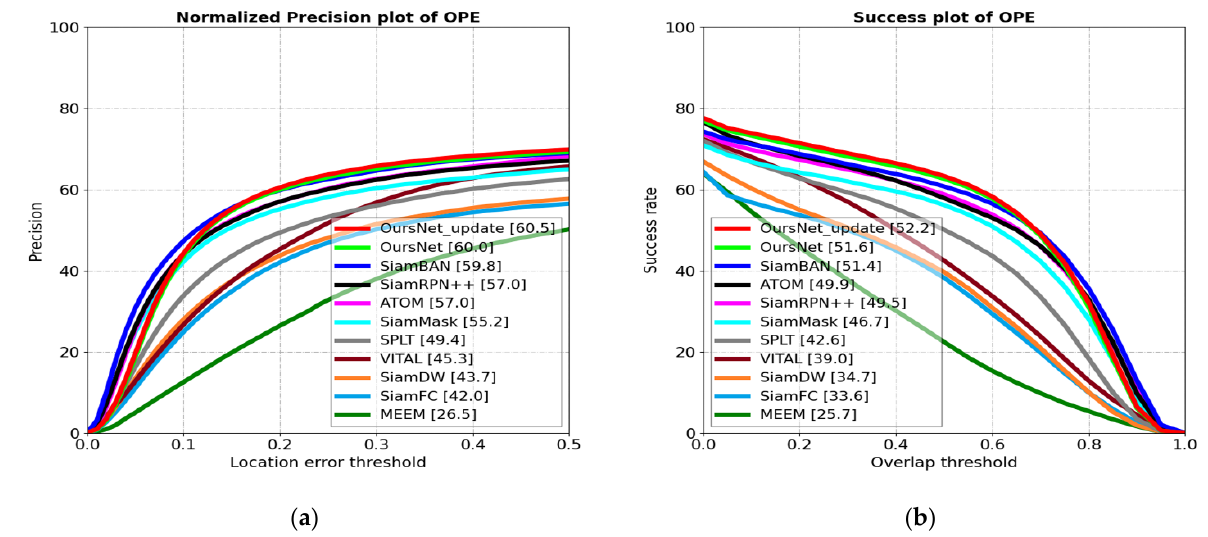
Figure 8. Performance evaluation results of different algorithms on LaSOT dataset. ( a ) Normalized precision plots; ( b ) success